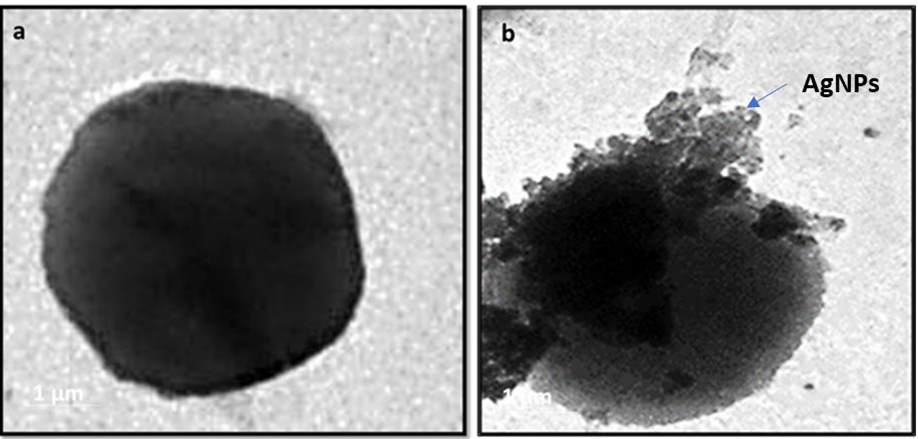
Figure 5. Accumulation of AgNPs on the S. aureus outer cell membrane ( a ) Bacteria with no treatment and ( b ) Bacteria treated with AgNPs.